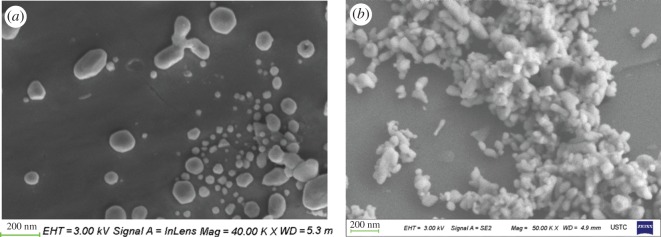
(a,b) SEM images of the NiOx–MoOy/SiO2 catalyst in the second stage.